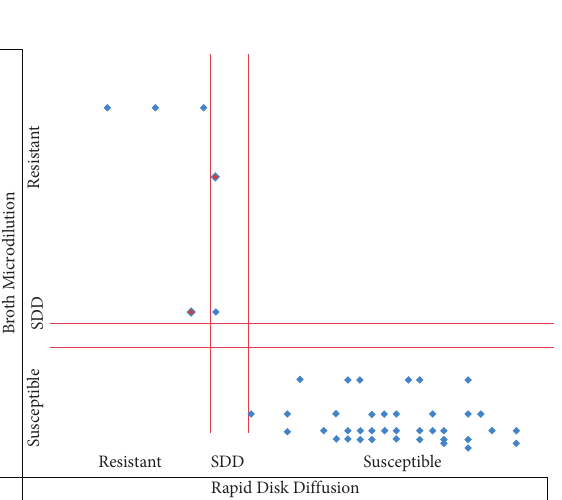
Figure 2: Distribution of susceptible profiles of Candida spp. according to the broth microdilution method and the rapid disk diffusion method. SDD: fluconazole susceptible-dose